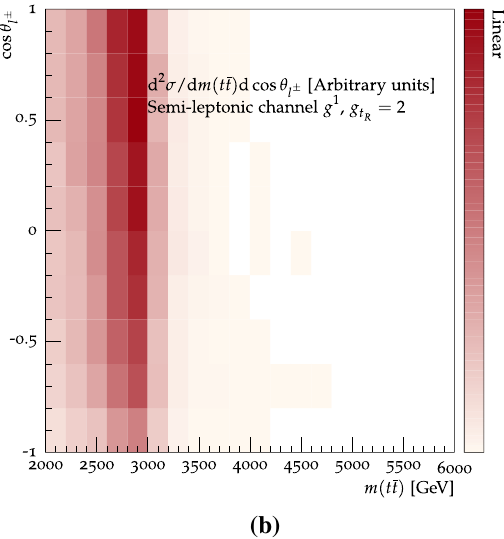
among our signal models from the perspective of gaining additional = 2) g 1 ( b ) in information from the polarisation R